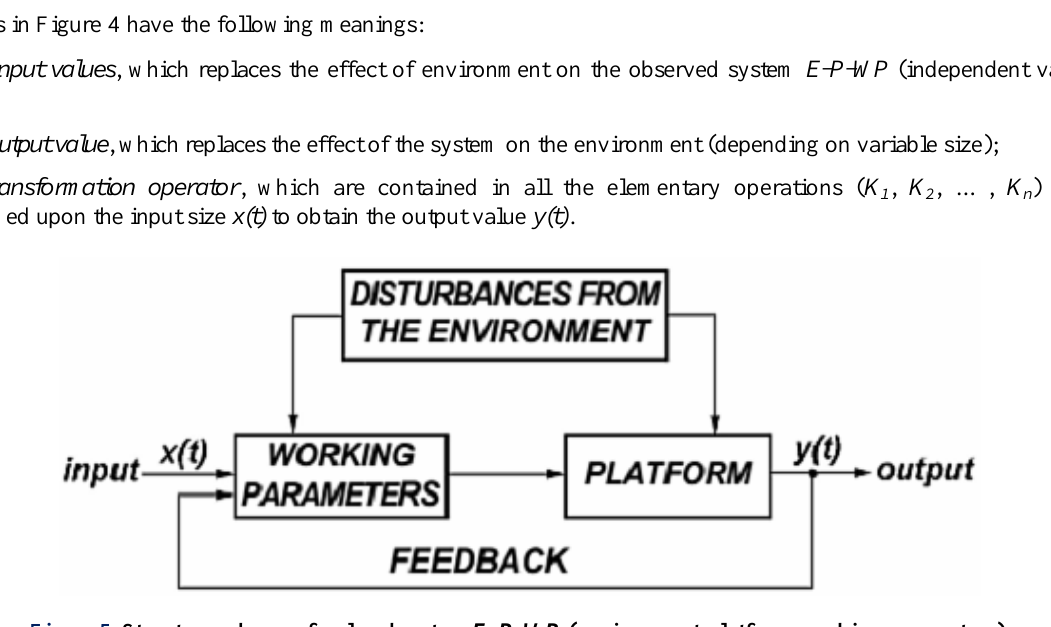
Figure 5. Structure scheme of a closed system E-P-WP (environment-platform-working